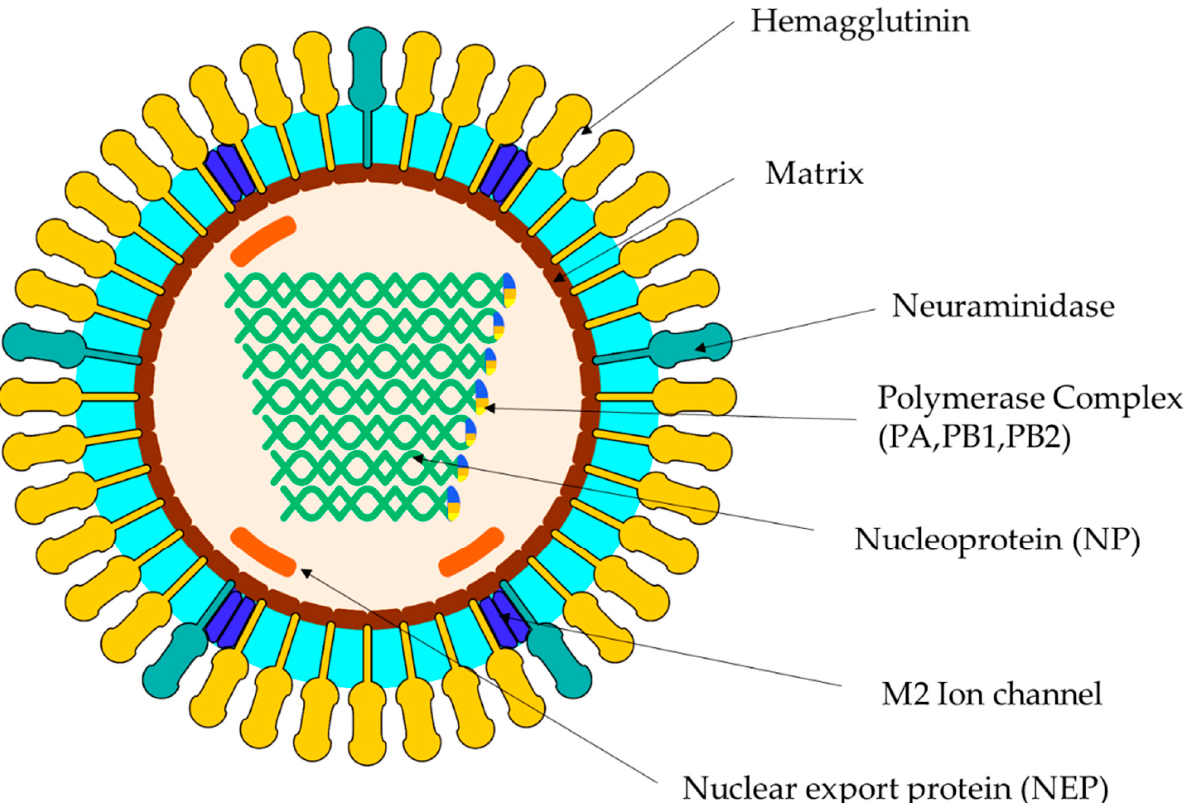
Figure 1. Diagram of the equine influenza virus structure and its genome. The diagram of the virion shows multiple proteins. See text for references.